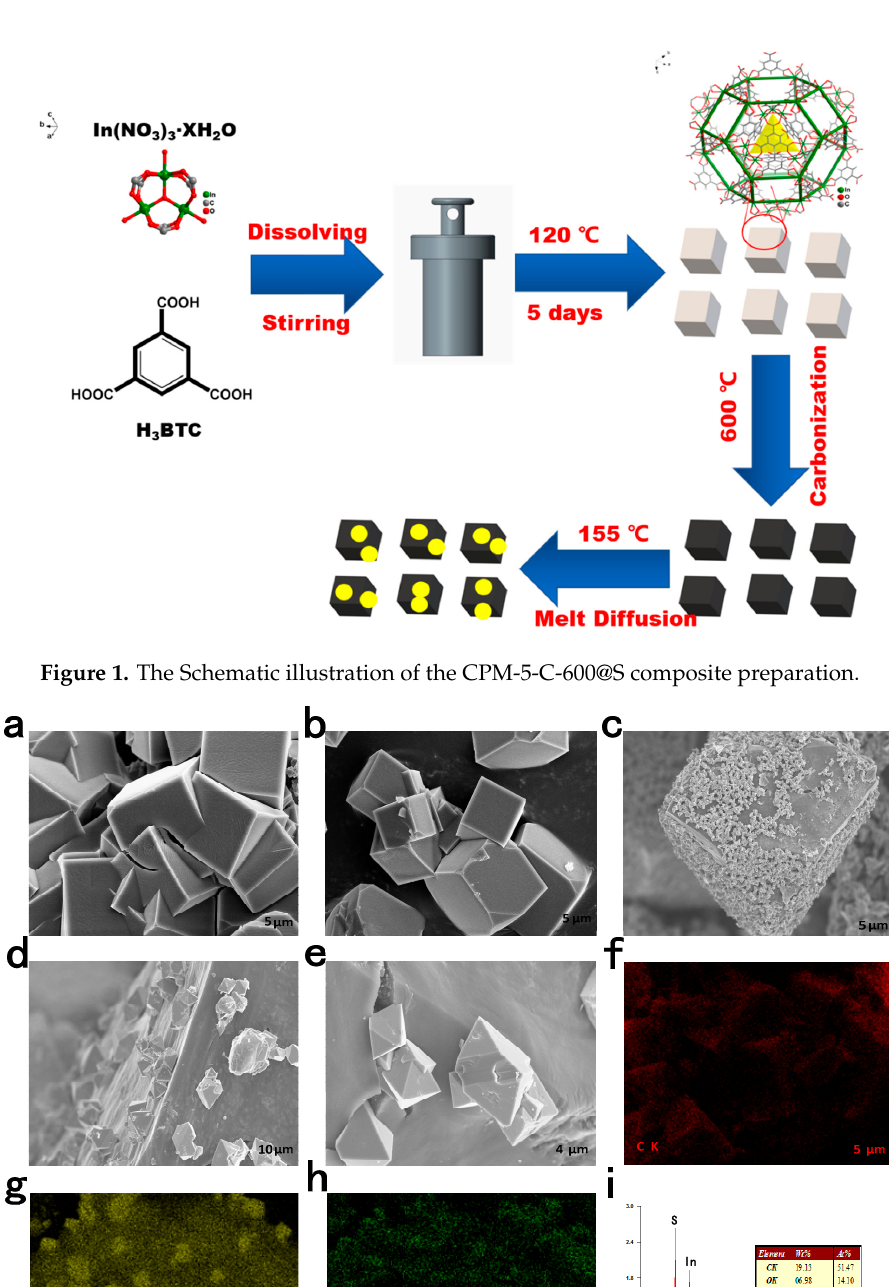
Figure 3. The XRD patterns ofCPM-5, S, AB, AB@S, CPM-5-C-600 and CPM-5-C-600@S composites. The pore structure characteristics and pore size distribution of CPM-5-C-600, CPM-5-C-600@S, AB, and AB@S samples were listed in the figure through Brunauer-Emmett-Teller (BET) test. As shown in Figure 4a, the adsorption desorption curve of CPM-5-C-600 material shows obvious mesoporous and microporous composite structure. Through pore size analysis, we could see that there is a type of micropores (less than 1 nm) and a small amount of mesoporous (2.5 nm) on the basis of Density Functional Theory (DFT) method. Through the pore distribution structure of CPM-5-C- 600, we speculate that when CPM-5-C-600@S was used as the cathode material of Li-S batteries, its